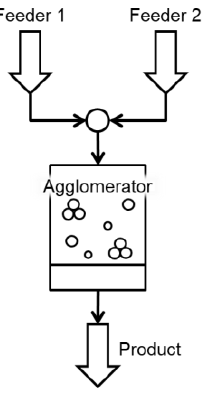
Figure 4. Flowsheet structure of the agglomeration process.